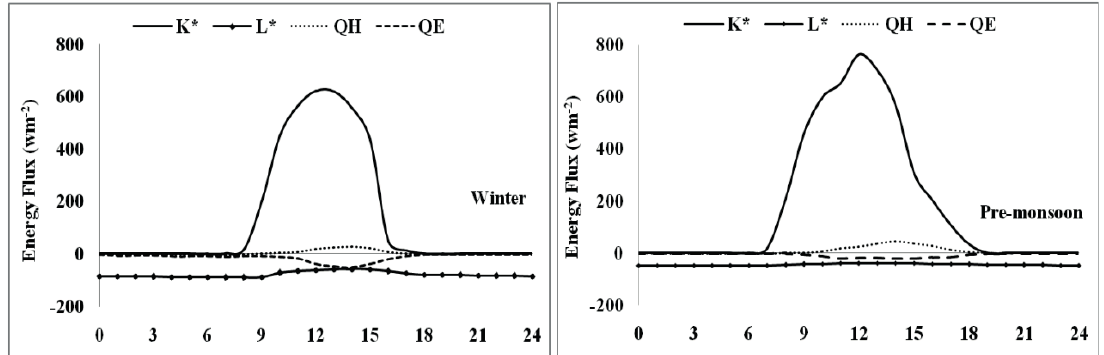
Fig. 3 Mean daily cycles of calculated surface heat fluxes for winter and the pre-monsoon season at the AWS site.